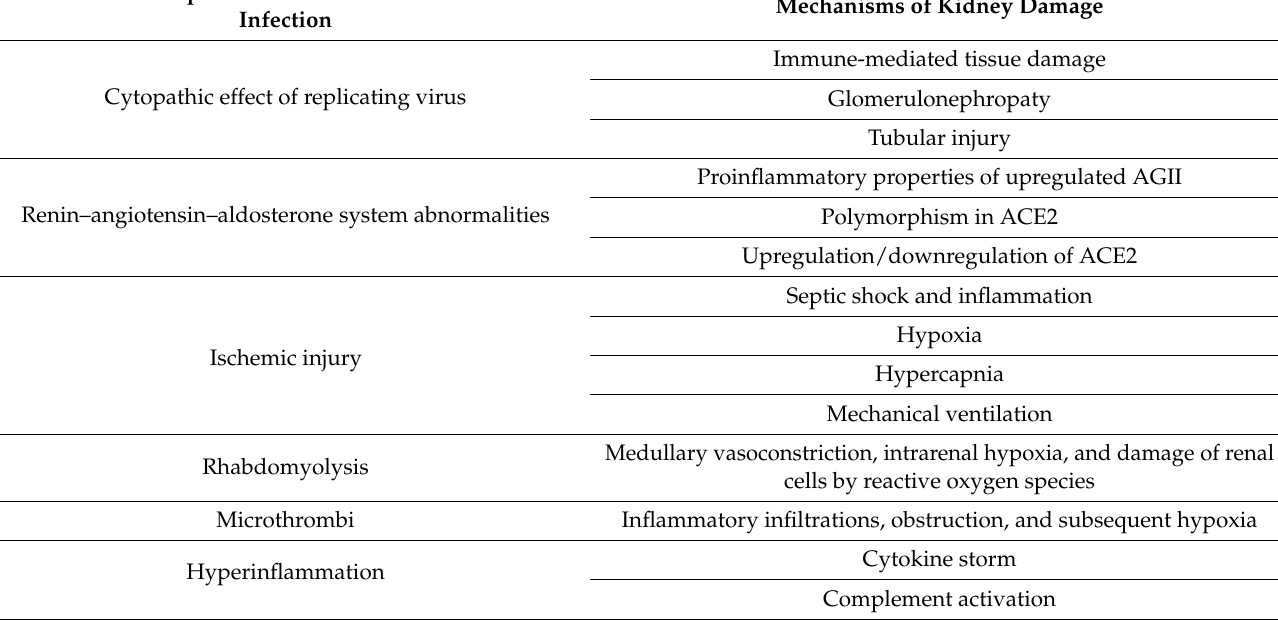
Table 2. Potential mechanisms of kidney damage associated with the SARS-CoV-2